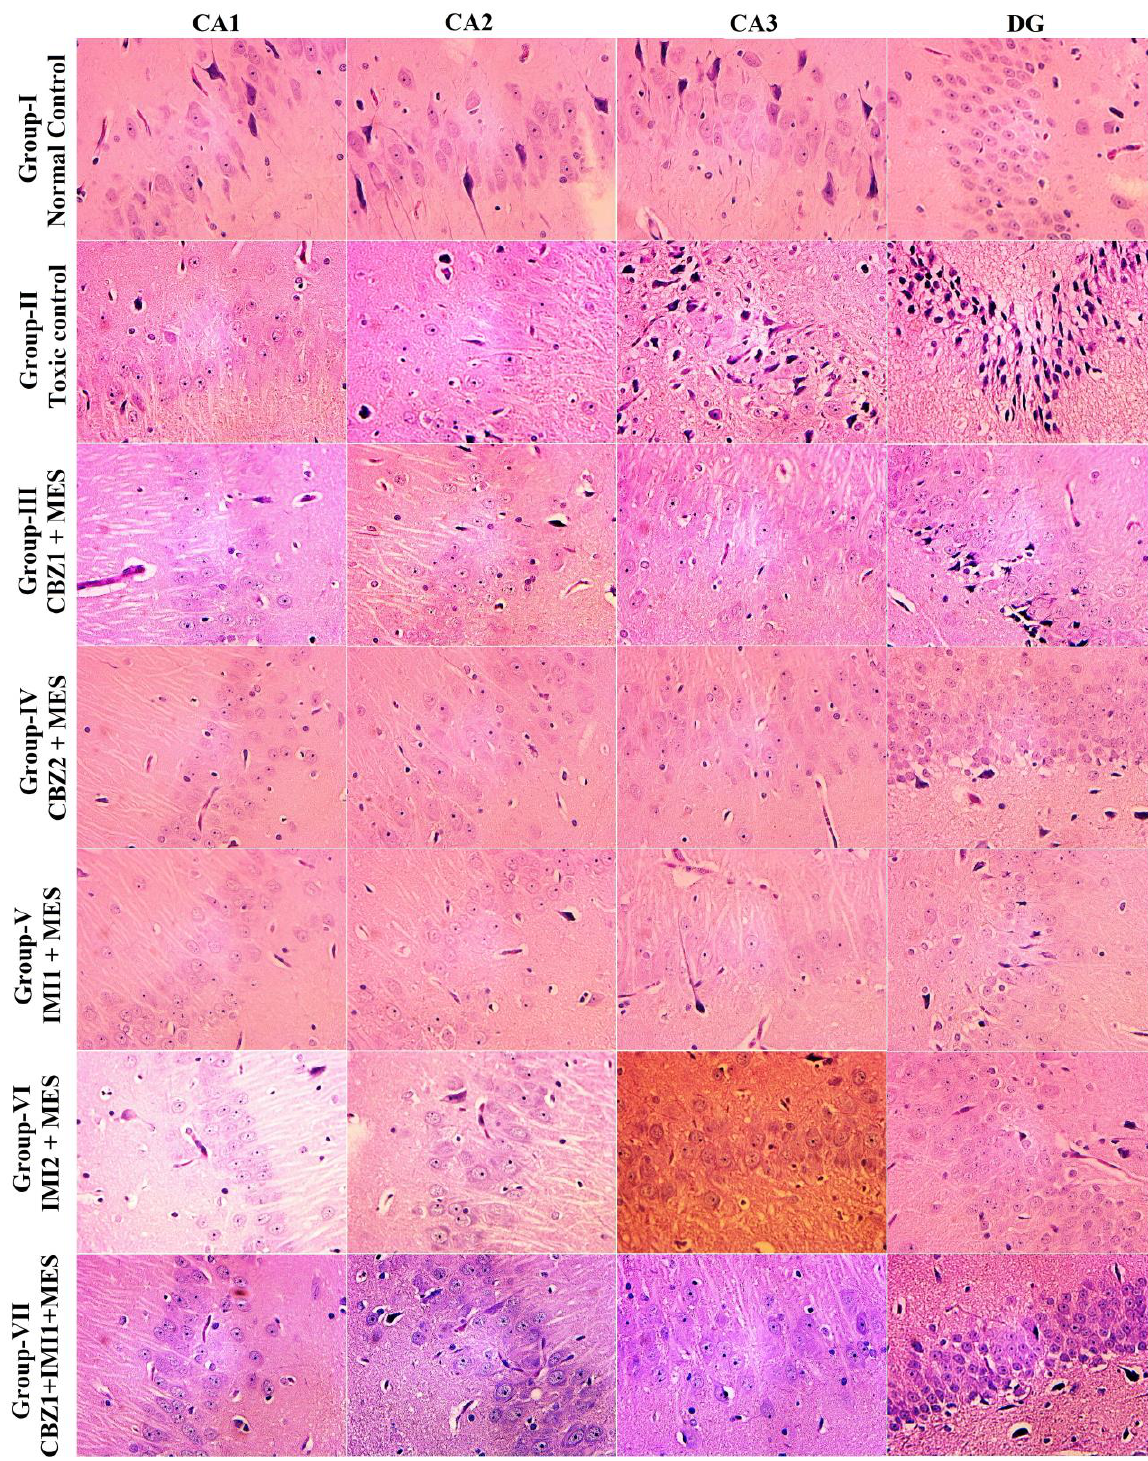
Figure 7. H/E stained rat hippocampal sections from normal control (group-I), toxic control (group-II) and drug-treated (groups III-VII). The differential effects of treatment with CBZ (20 and 50 mg/kg), IMI (10 and 20 mg/kg) and CBZ (20 mg/kg) + IMI (10 mg/kg) on the hippocampal neurons after electroshock are shown. It seems that the higher doses of CBZ and IMI are more protective against deteriorating effects of electric shock (normal neuronal density is more in those groups), compared to their lower doses. Howbeit, the combination therapy seemed to largely restrict the damage in CA1, CA2 and DG areas, while the neuronal density of the CA3 region seems to be reduced. Clearly the neuroprotective effects of the combination group exceed other treated groups.